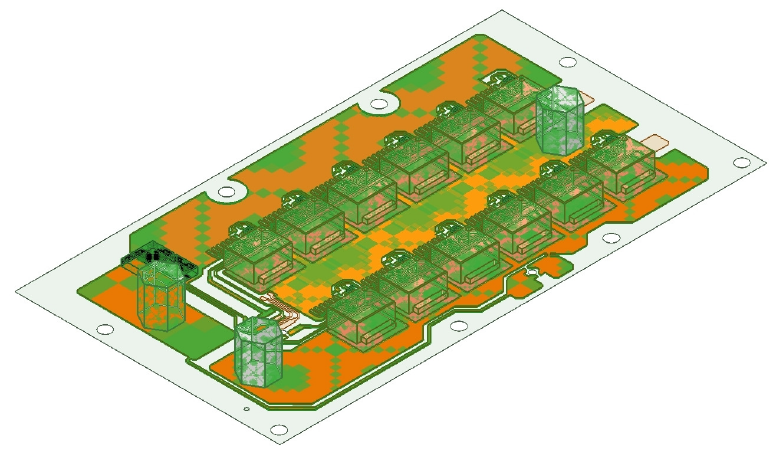
Figure 3. Identification of the NETs in Q3D Extractor, with the assignment of source and sink, to obtain the relative values of resistance, inductance, and capacitance.